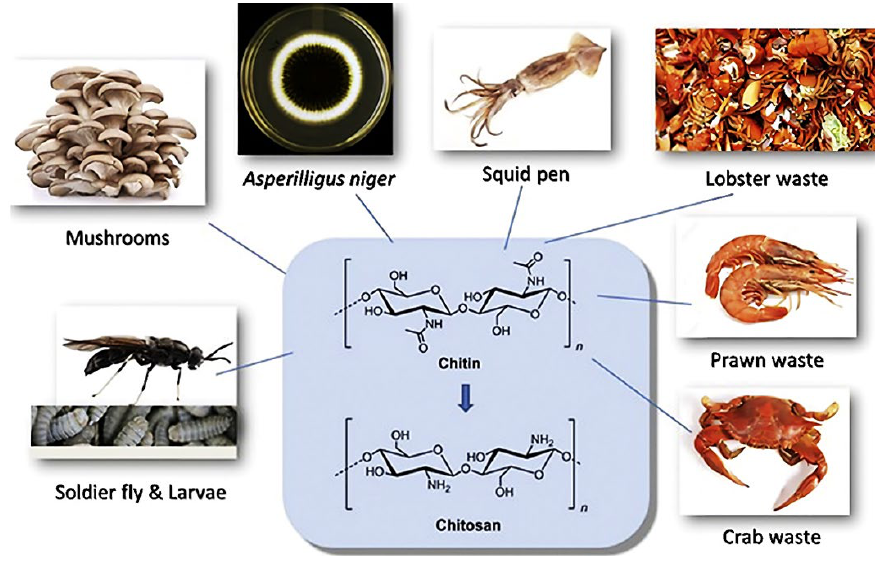
Figure 3. The chitin sources. Reproduced with permission from [66].